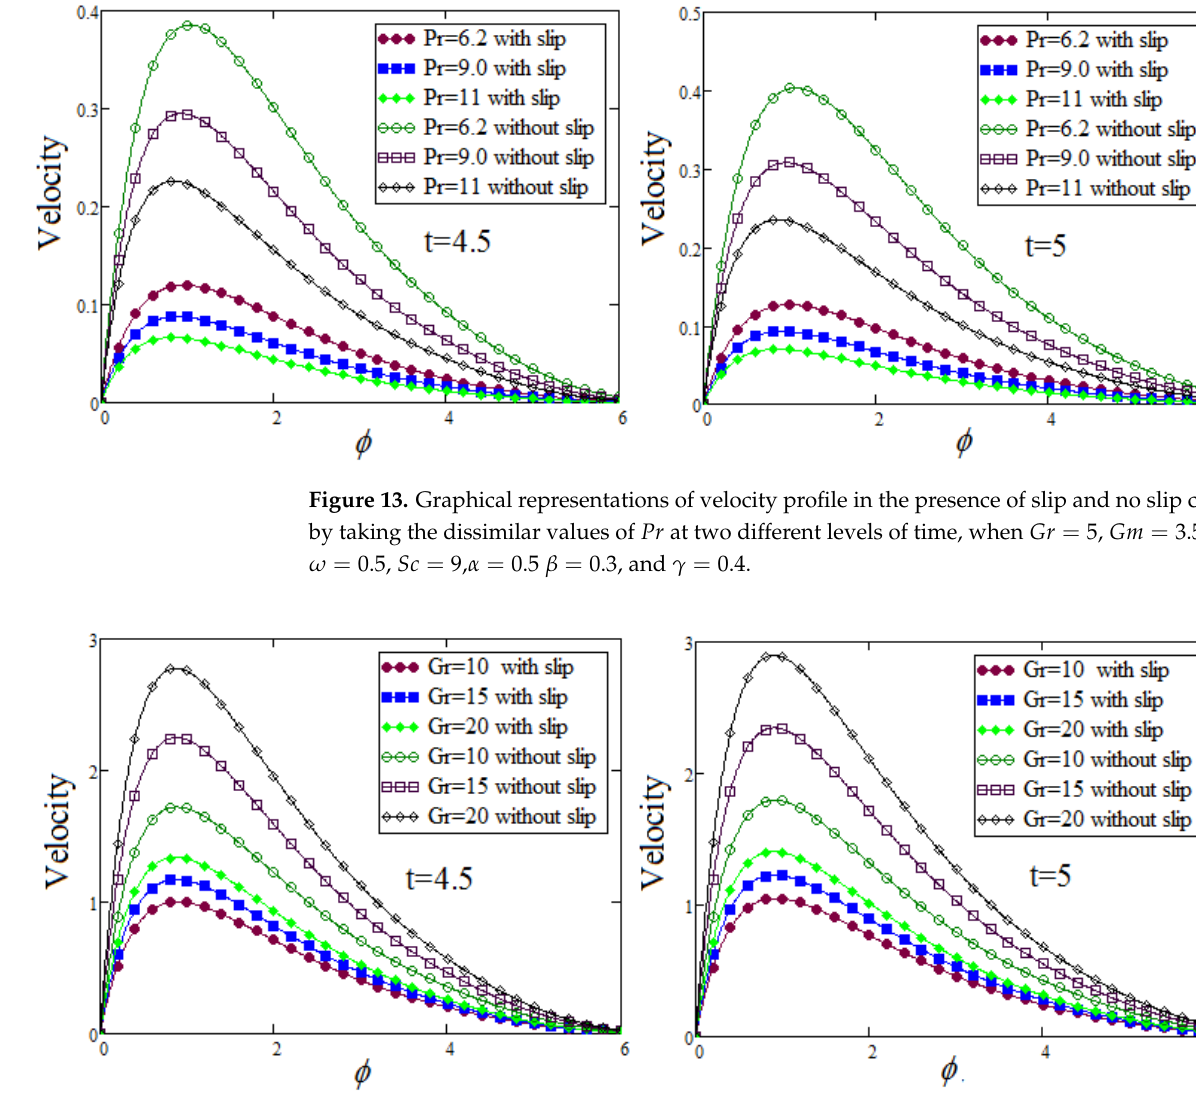
Figure 14. Graphical representations of velocity profile in the presence of slip and no slip conditions by taking the dissimilar values of Gr at two different levels of time, when Pr = 12, Gm = 3.5, ℘ = 0.4, ω = 0.5, Sc = 9, α = 0.5 β = 0.3, and γ =